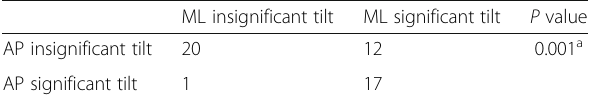
Table 3 Comparison between anteroposterior and mediolateral tilt in patient group